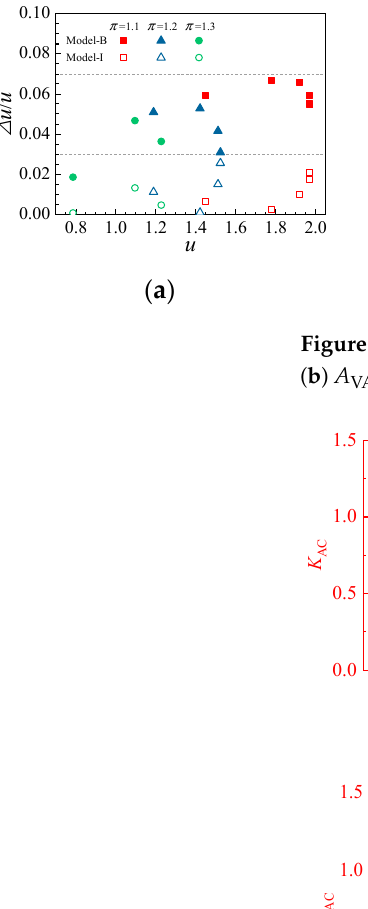
Figure 10. The comparison of simulation error of the theoretical VABI models: ( a ) A VABI = 0.8; ( b ) A VABI = 0.6; ( c ) A VABI = 0.4.